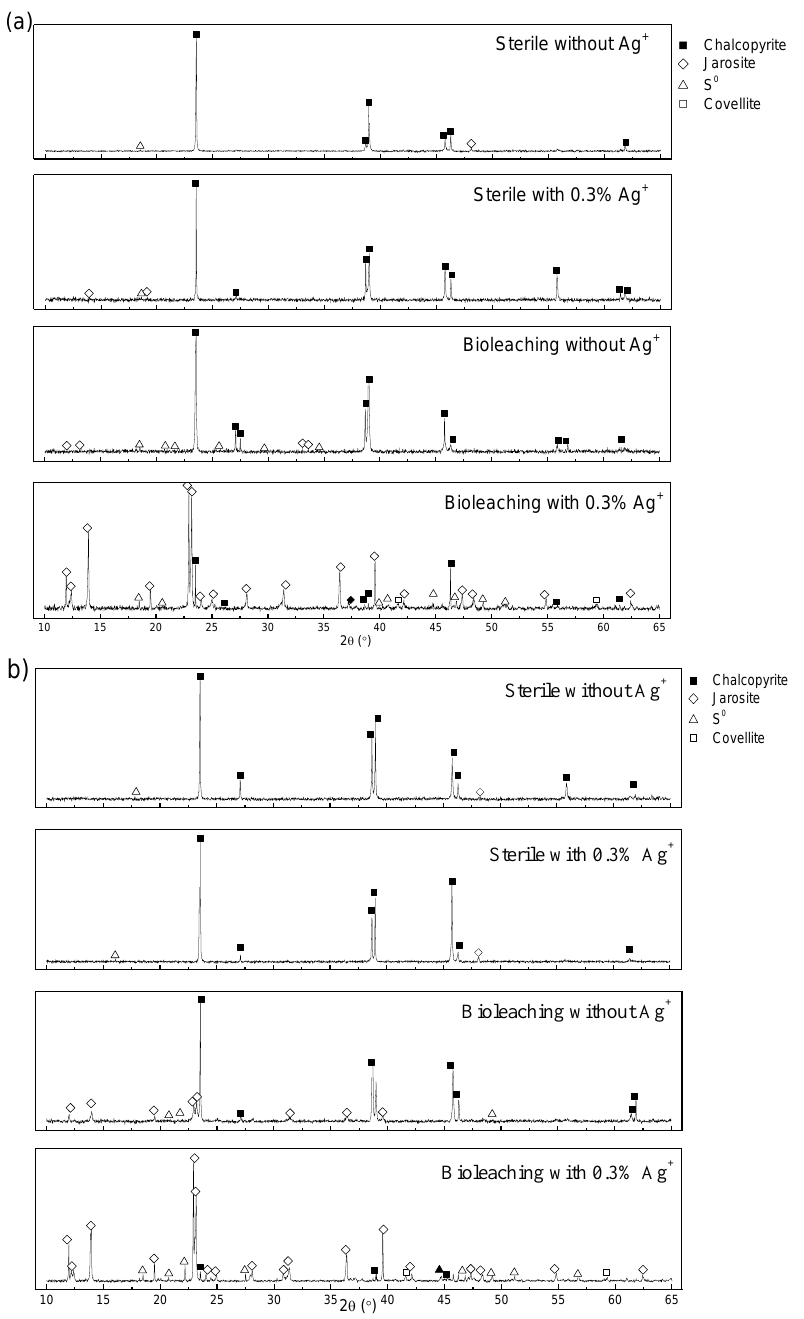
Figure 5. SR - XRD patterns of leaching residues by mesophilic culture and in sterile control at 30 °C without Ag + and with 0.3% of Ag + ( a ) and SR - XRD patterns of leaching residues by thermophilic culture and in sterile control at 48 °C without Ag + and with 0.3% of Ag + ( b